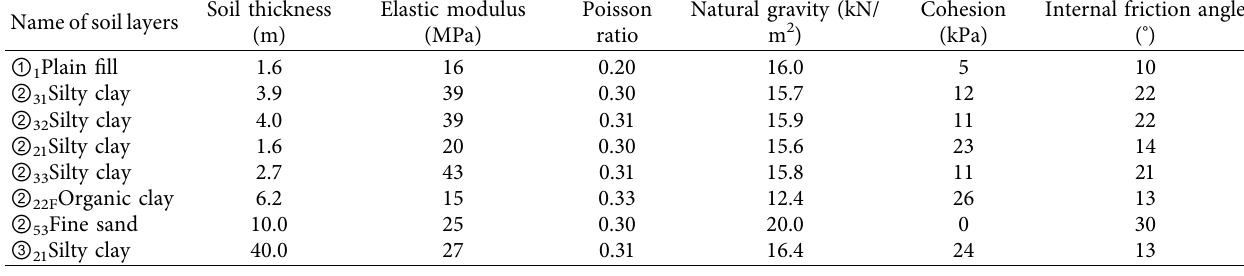
Table 1: Soil physical and mechanical parameter values.